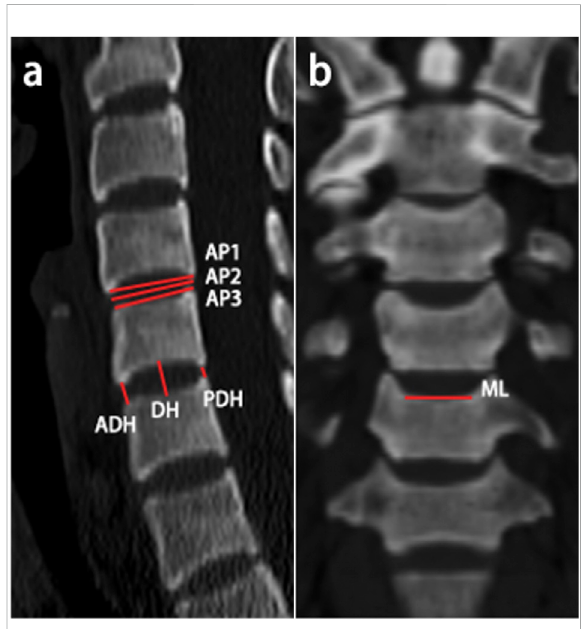
FIGURE 1 Schematicrepresentationofthemeasuredlinearparameters. (A) The anterior-posterior diameter and anterior/middle/posterior disc height were measured in sagittal CT scans; (B) The center mediolateraldiameterofthesuperiorvertebralendplateswas measured in coronal CT